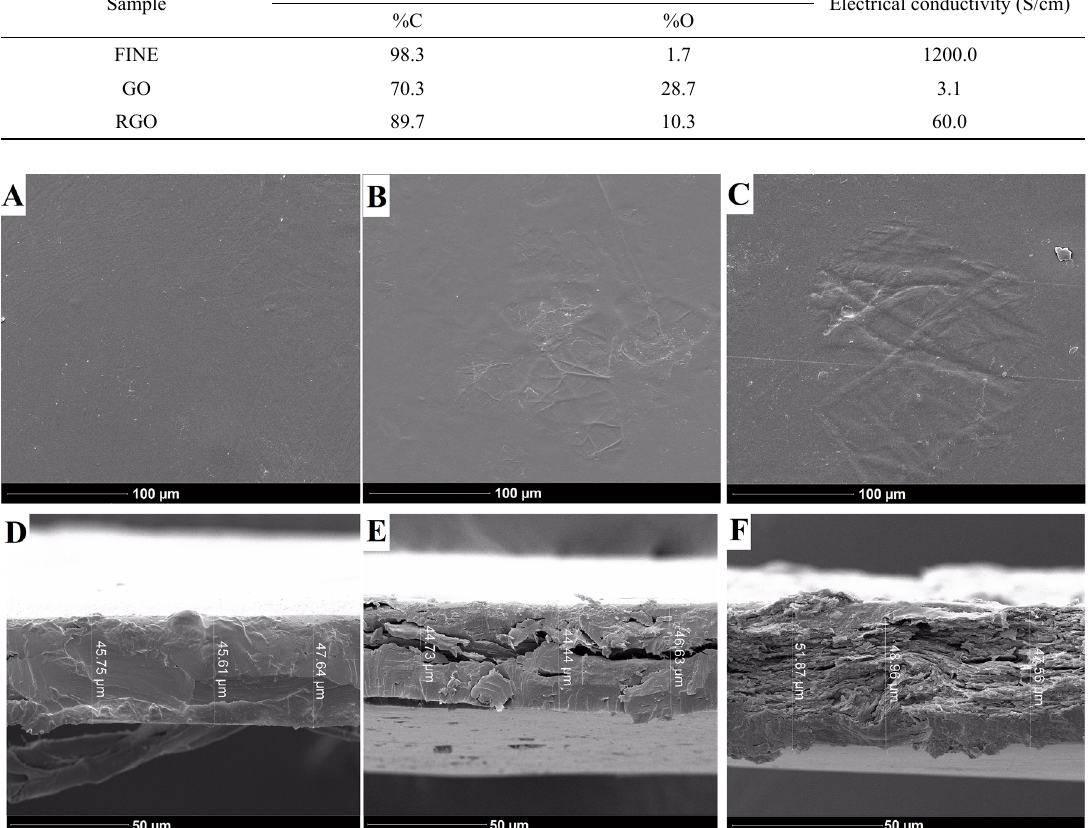
Figure 4. FESEM of the surface of CS (A), CS/GO3 (B) and CS/RGO3 (C). FESEM of the cross-section: CS (D), CS/GO3 (E) and CS/RGO3